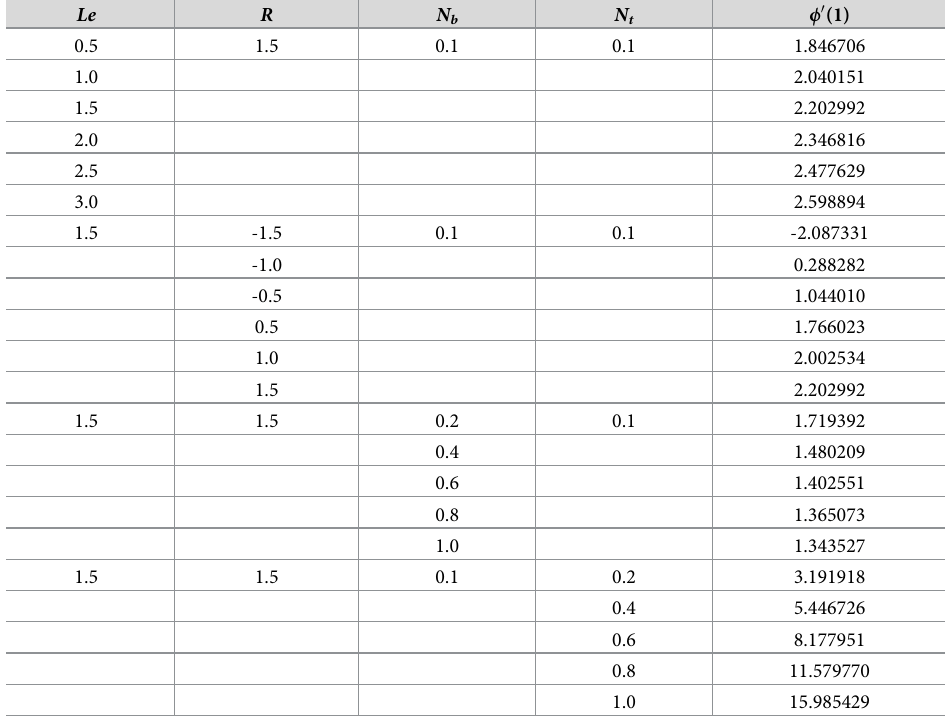
Table 7. Numerical outputs of ϕ 0 (1) for Le , R , N b and N t when γ = De = 0.01, δ = S = Da = 1, Ha = Ec = R d = 0.1 and Pr = λ 1 = 1.5. Le R N b N t ϕ 0 (1)